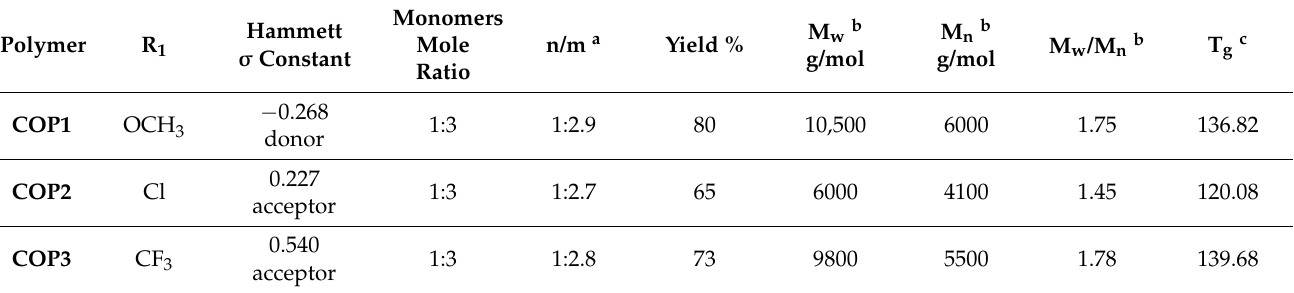
Table 1. Material properties of studied copolymers.